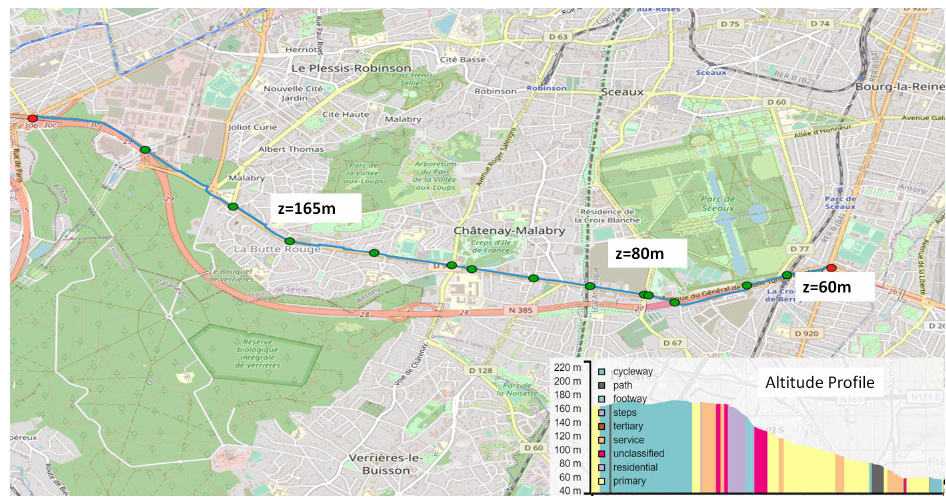
Figure 3. Altitude profile over the blue path across the city, with the various types of road. Source: https://www.maps.ie/map-my-route/(accessed on 18 August 2022). Cartography: